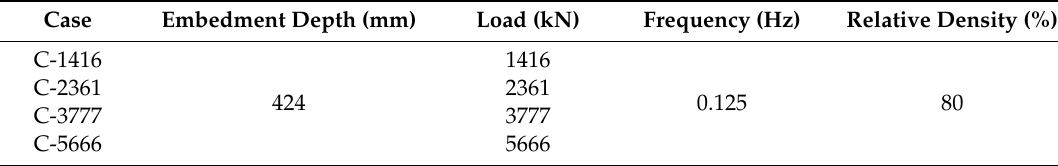
Table 4. Cyclic loading test